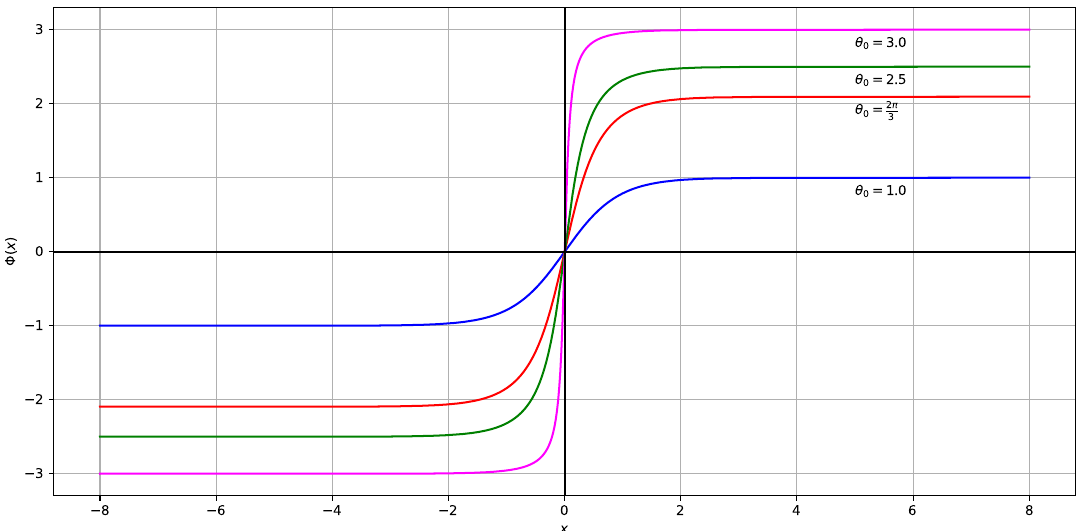
Figure 17 . Numerically simulated kinks Φ( x ) for the set of parameters θ 0 = { 1 , 2 π blue, red, green and purple lines,